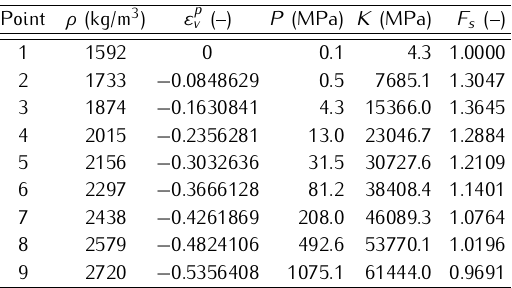
Table 6. Tabular data for sandy gravel with 0.9% average moisture